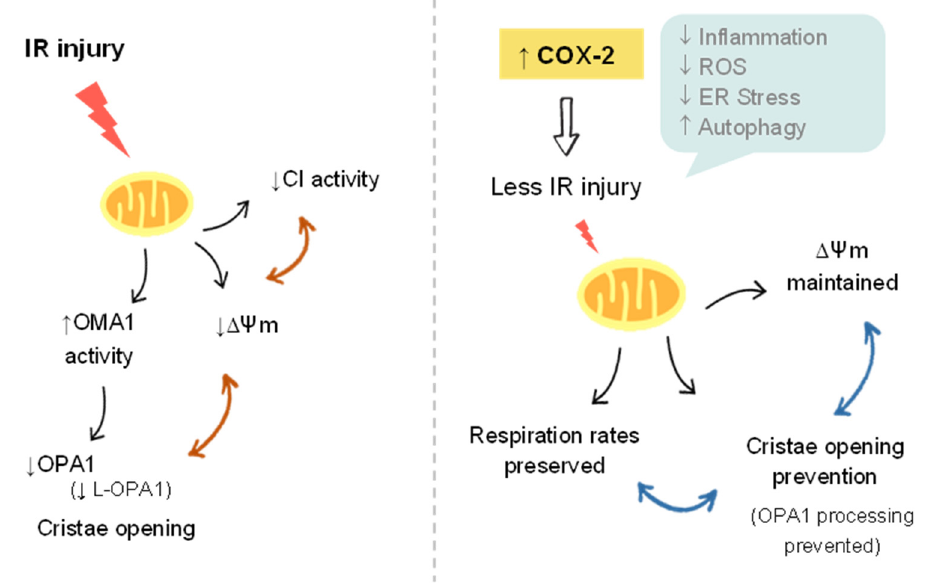
Figure 7. Model of mitochondrial damage after I/R. Comparison between Wt and h-COX-2 Tg livers. In Wt conditions, I/R injury directly impacts mitochondria, decreasing mitochondrial membrane potential ( ∆Ψ m), affecting complex I activity and activating the enzyme OMA1. OMA1 processes OPA1, leading to a reduced presence of the long form of OPA1 (L-OPA1), causing a destabilization of the cristae and leading to their opening. In the presence of h-COX-2, I/R injury in the livers is reduced, therefore mitochondria are less affected: ∆Ψ m is preserved, complex I maintains its function and cristae remain tight. All these data are integrated with COX-2 protection mechanisms previously described in [28].